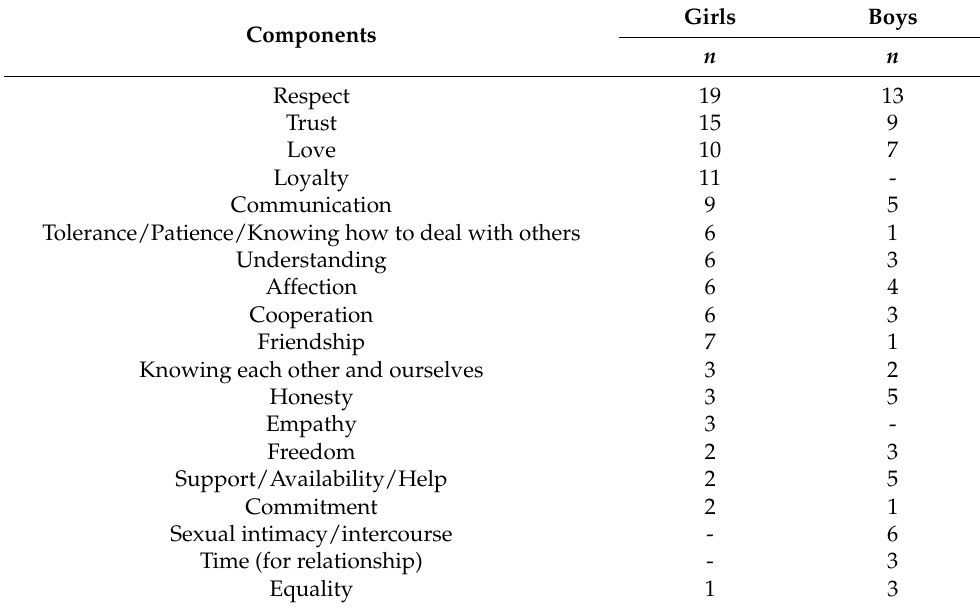
Table 5. Components of a healthy